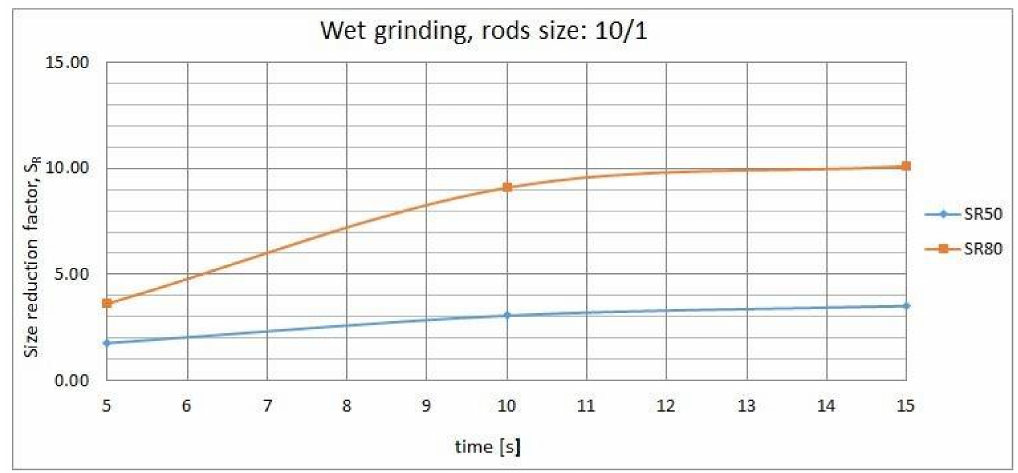
Figure 14. Comparison of S R factors for wet grinding with 10/1 rods and 1600 kg/m 3 density.